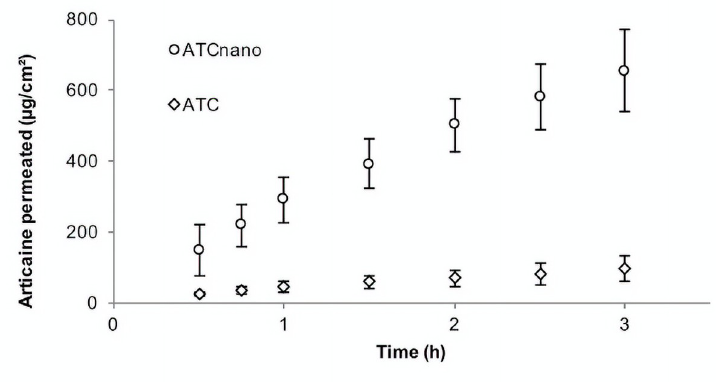
Fig 4. Permeation profiles (mean ± SD, n = 6–8) of ATC permeated after 3 h, for ATC permeation across fresh swine esophageal epithelium from formulations applied under infinite dose conditions. White circles: ATC nano (articaine-loaded poly( ε -caprolactone) nanocapsules; white diamonds: ATC (articaine).